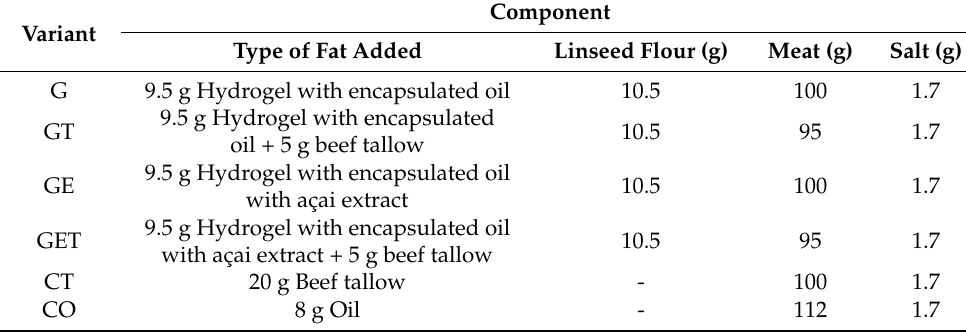
Table 9. Beef burger